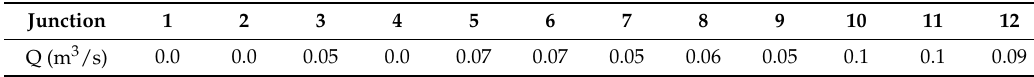
Table 2. Demand at